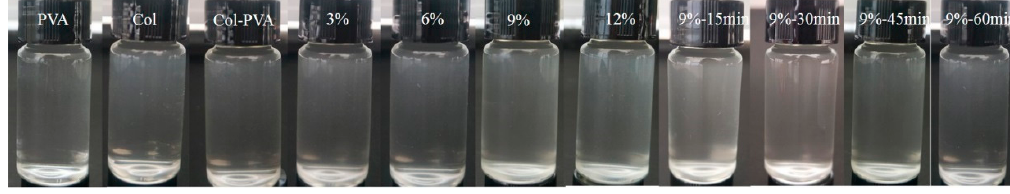
Figure 2. Photograph of composite film solution.